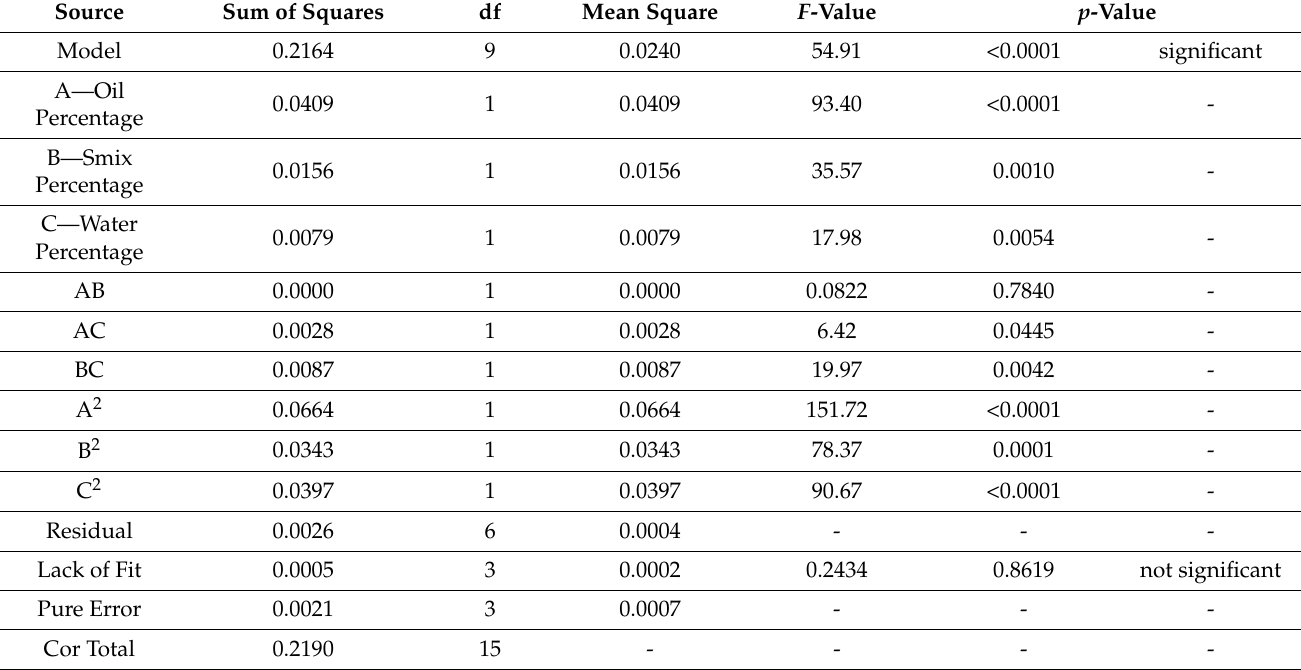
Table 5. ANOVA data for PDI of ETB-NE